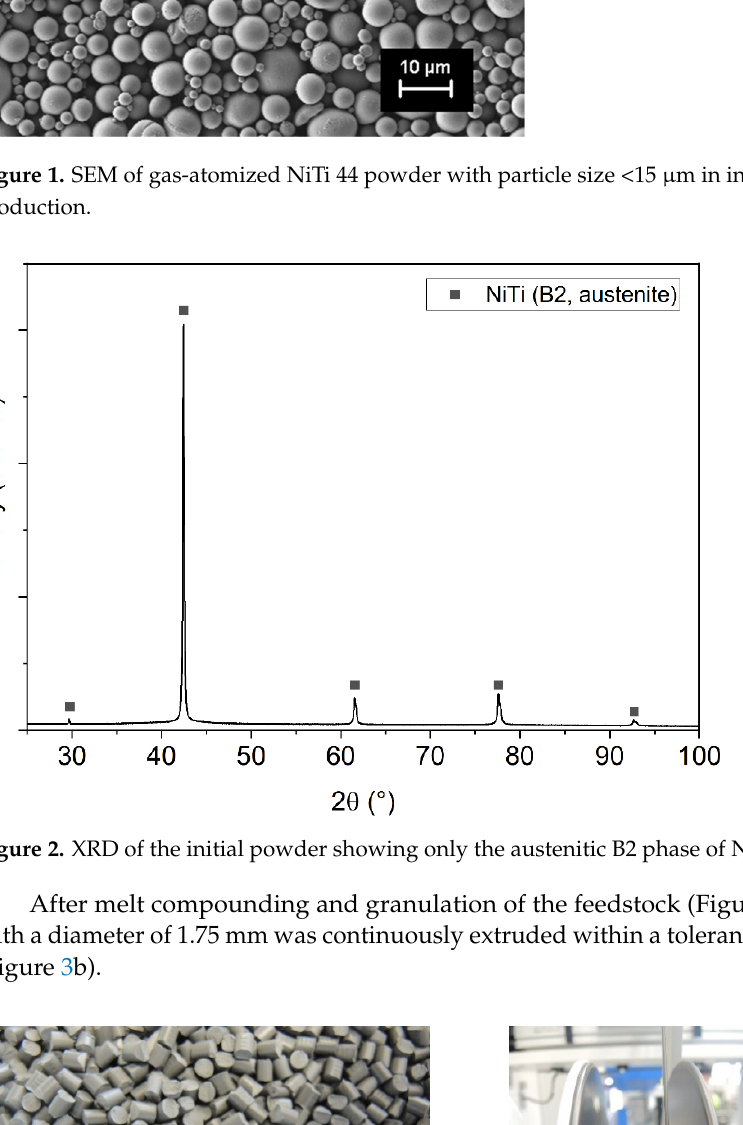
Figure 1. SEM of gas-atomized NiTi 44 powder with particle size <15 µm in initial state for filament production.